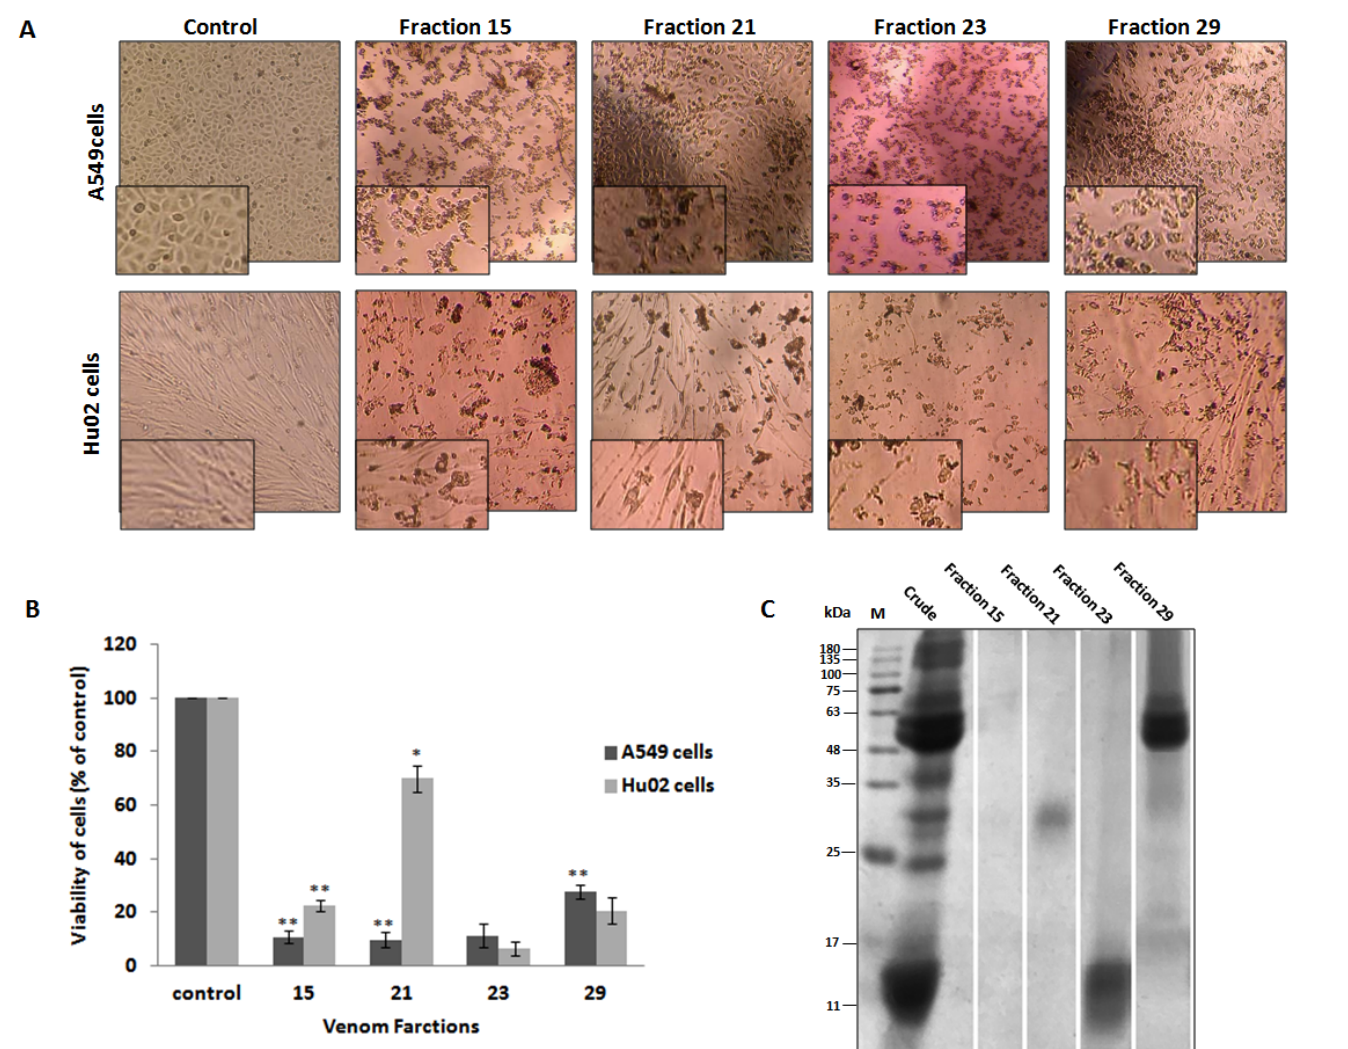
Figure 4. Analysis of cytotoxic fractions of P. persicus venom. ( A ) Morphological observation of A549 and Hu02 cells treated with HPLC fractions 15, 21, 23 and 29 under phase-contrast inverted microscope (magnification 100×). The A549 and Hu02 cells were treated with 20 µg/mL isolated fractions and incubated for 24 hours in 96-well plates. The morphological changes in the cells treated with cytotoxic fractions are displayed here. Untreated cells comprise the control group. ( B ) Effect of cytotoxic fractions of P. persicus venom on A549 and Hu02 cells. The cells were treated with 20 µg/mL of fractions 15, 21, 23 and 29 for 24 hours and the viability of the cells was evaluated by MTT test. Untreated cells comprise the control group. Values were presented as means ± SD (n = 3). Statistical significance versus control (*p < 0.05; **p < 0.01; ***p < 0.001). ( C ) SDS-PAGE analysis of cytotoxic fractions under reduced conditions. M: Molecular mass